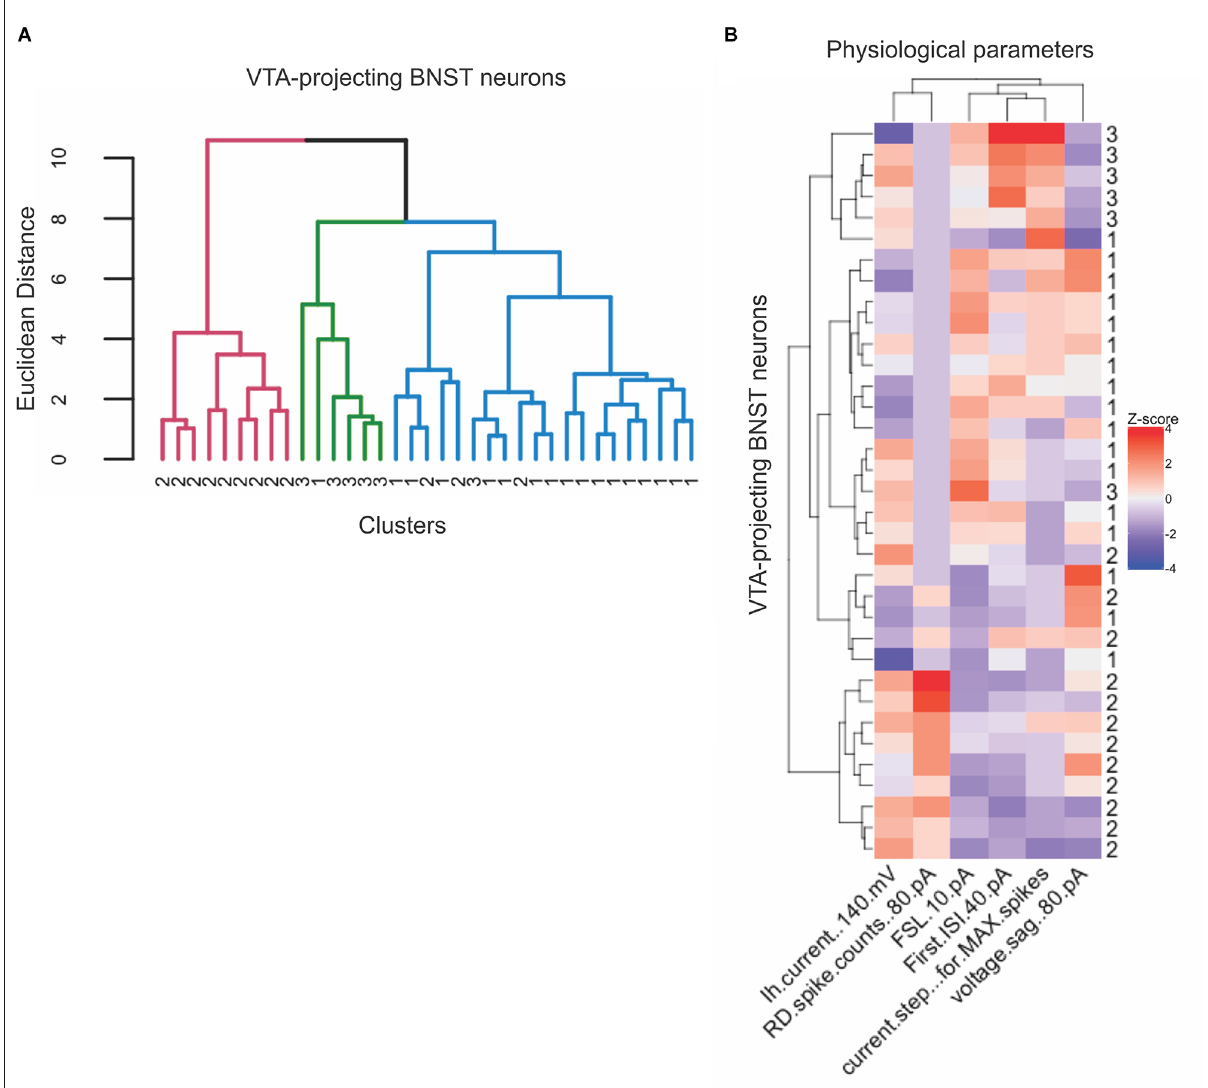
FIGURE10 Three neuronal types emerge from hierarchical analysis with six electrophysiological parameters of VTA-projecting BNST neurons. (A) Dendrogram showing hierarchical clustering using Euclidean distance and Ward’s method ( n = 35 neurons = 17 mice). (B) Heatmap of neuron features clustered neurons and physiological parameters that were used for